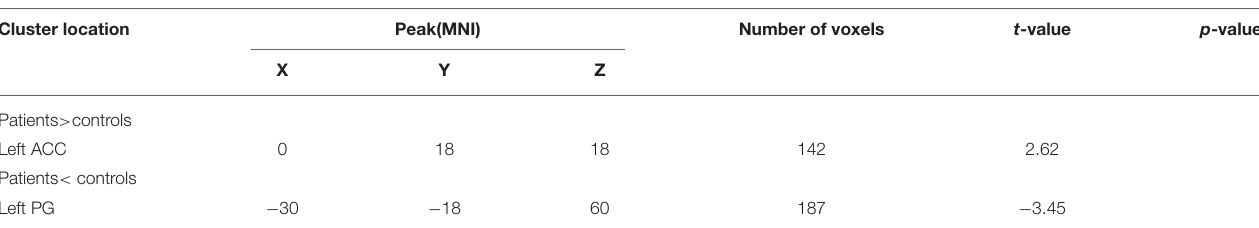
TABLE 2 | Brain regions with abnormal ReHo in MDD. Cluster